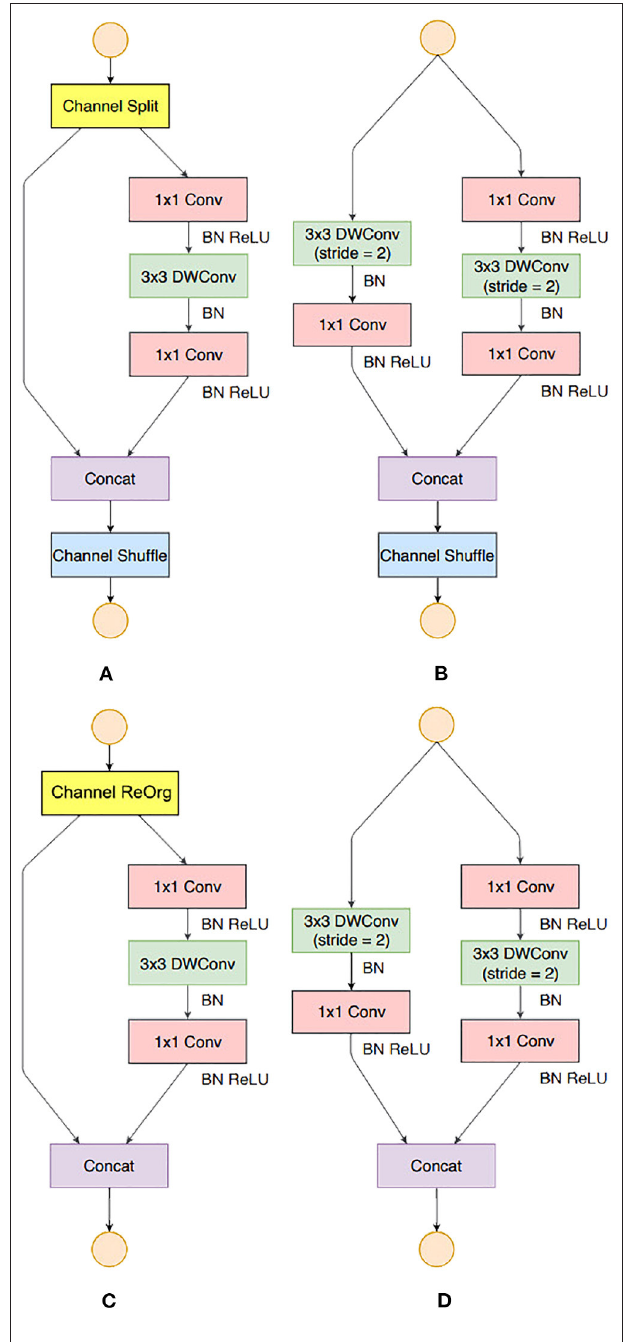
FIGURE 8 | Building Blocks of ShuffleNet v2 and this study. (A) the basic ShuffleNet v2 unit; (B) the ShuffleNet v2 unit for spatial down sampling (2 × ); (C) our basic unit; (D) our unit for spatial down sampling (2 × ).